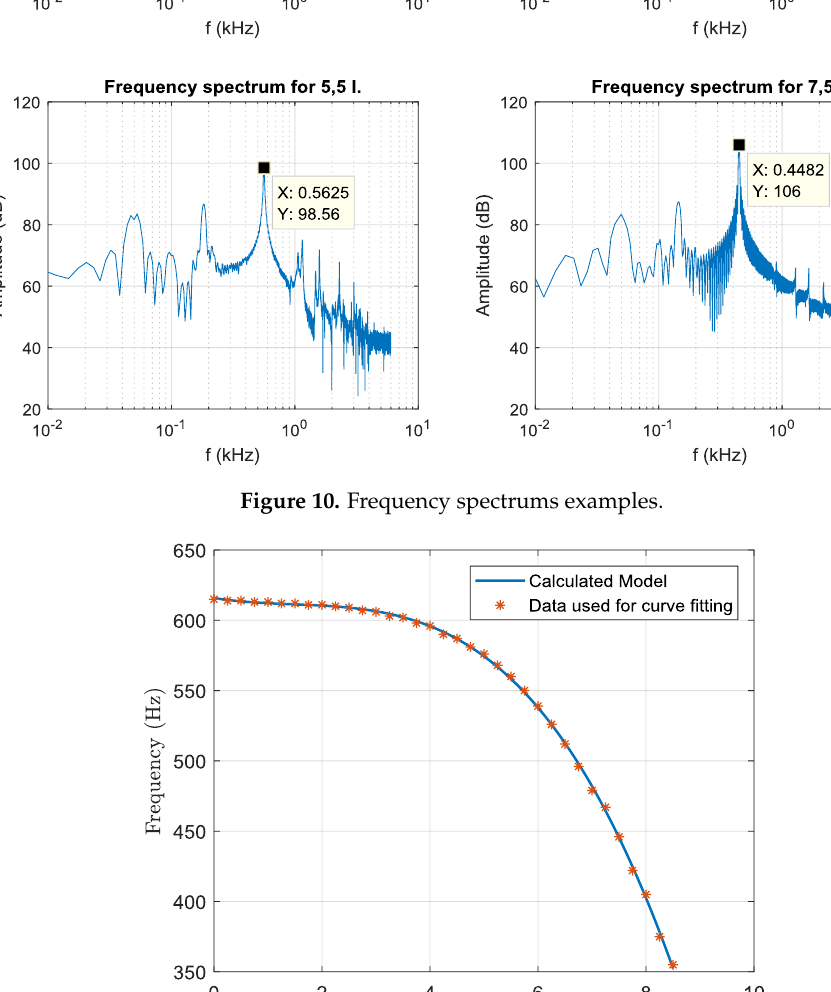
Figure 11. The model obtained from calibration vs. measured points.